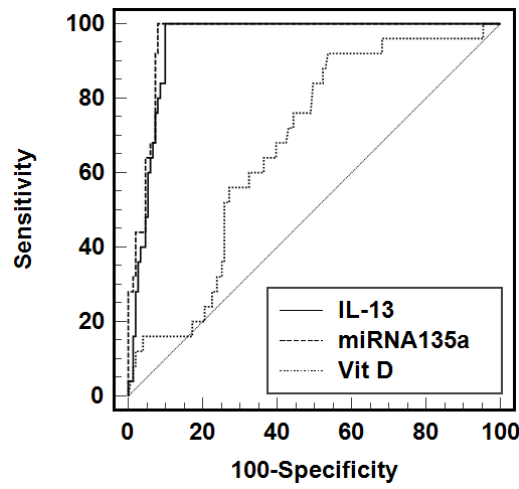
Figure 2. Diagnostic accuracy of IL-13, miRNA-135a and vit D to predict treatment failure and HCC with the best predictive cut offs. ( a ) ROC analysis to discriminate between responders and non-responders using IL-13, miRNA-135a, and vit D. ( b ) ROC analysis to predict the development of HCC among HCV-infected patients using IL-13, miRNA-135a, and vit D. ROC curves to predict DAA therapy failure in non cirrhotic ( c ) and cirrhotic patients ( d ) using the previous mentioned markers. ( e ) ROC curve to predict the development of HCC among cirrhotic patients.